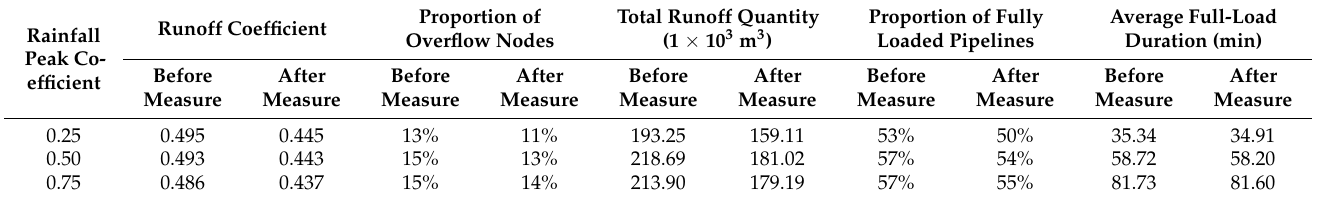
Table 11. Statistical analysis on the drainage capacity under different rainfall peak